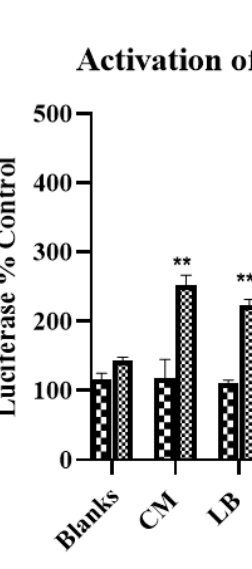
Figure 9. Activation of the antioxidant response element (ARE) in RAW 264.7 macrophages by air samples from CM, LB and SB. Cells transfected with ARE-luciferase cDNA were exposed to either PM2.5 and VOC from CM, LB, SB at 1 m 3 / mL for 16 h and ARE activation assessed; (see Methods for ARE procedures). Each value is the mean ± SD, n = 4 / sample site; site values normalized to corresponding blanks; CM VOC vs. CM PM2.5, ** p < 0.005; LB VOC vs. LB PM 2.5, SB VOC vs. SB PM2.5, *** p < 0.00001.